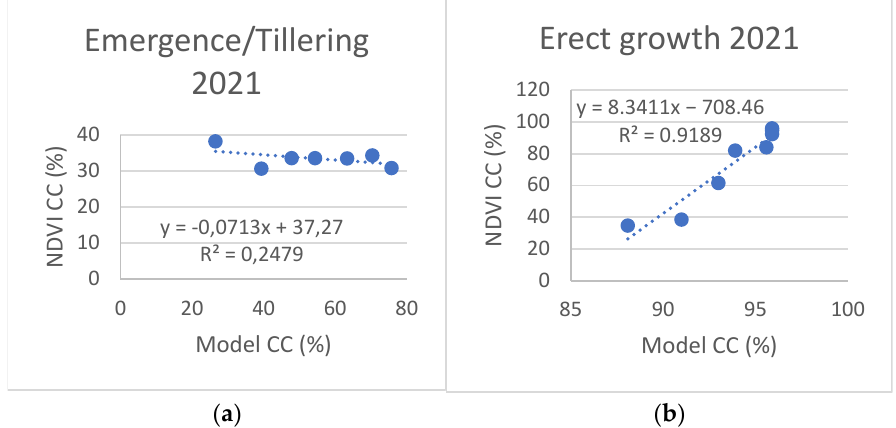
Figure 9. Comparison between NDVI and model-based canopy cover for emergence/tillering ( a ) and erect growth ( b ) of winter wheat, 2021.